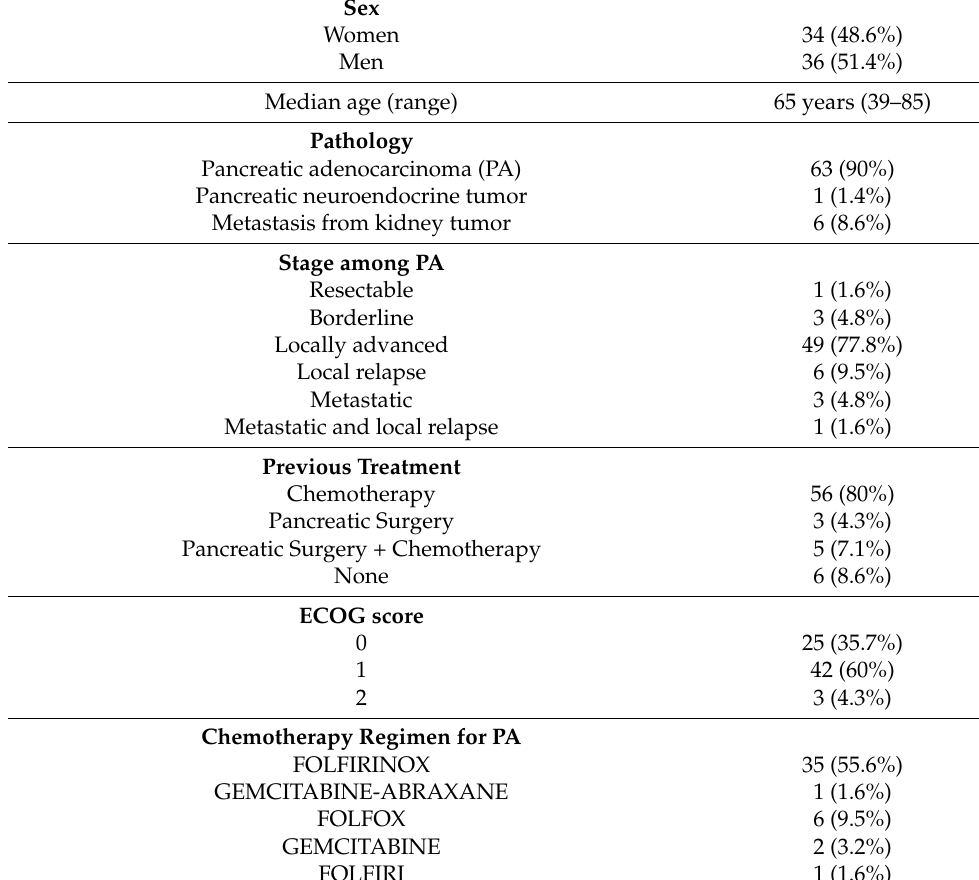
Table 1. Patients baseline